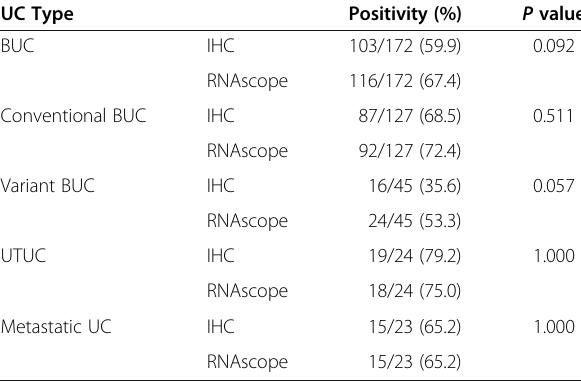
Table 4 Comparison of UPK2 status detected by IHC and RNAscope in different UC